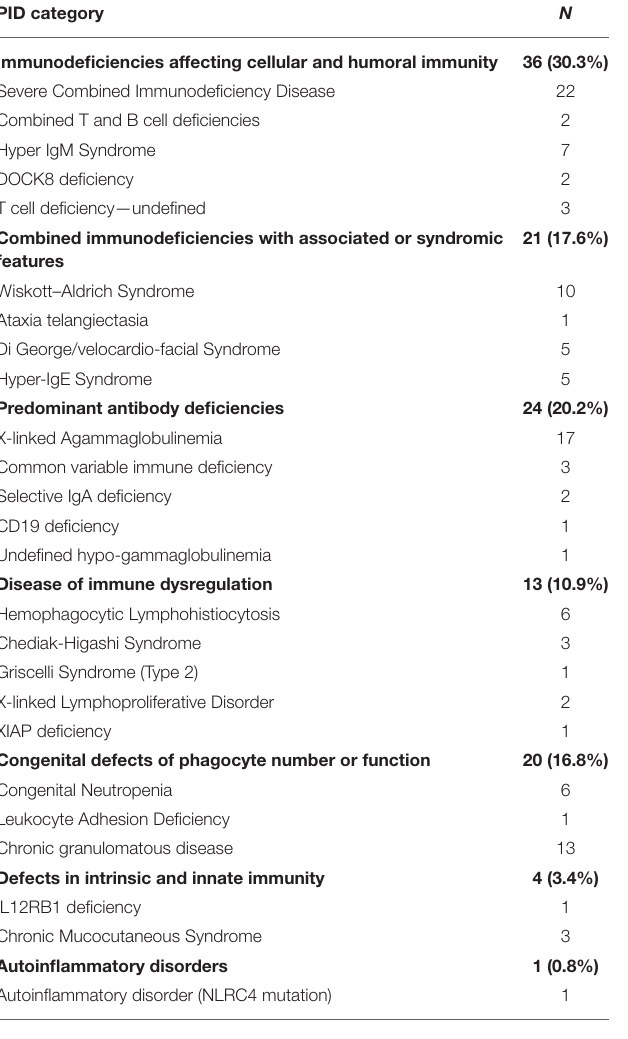
TABLE 2 | Spectrum of PIDs, 1979–2020. PID category